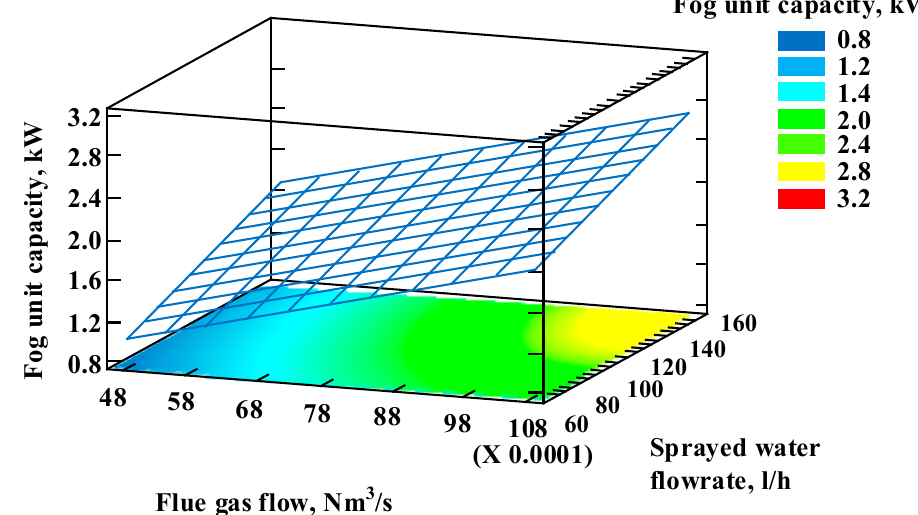
Figure 3. Q fu response surface depending on varying V g and G values.